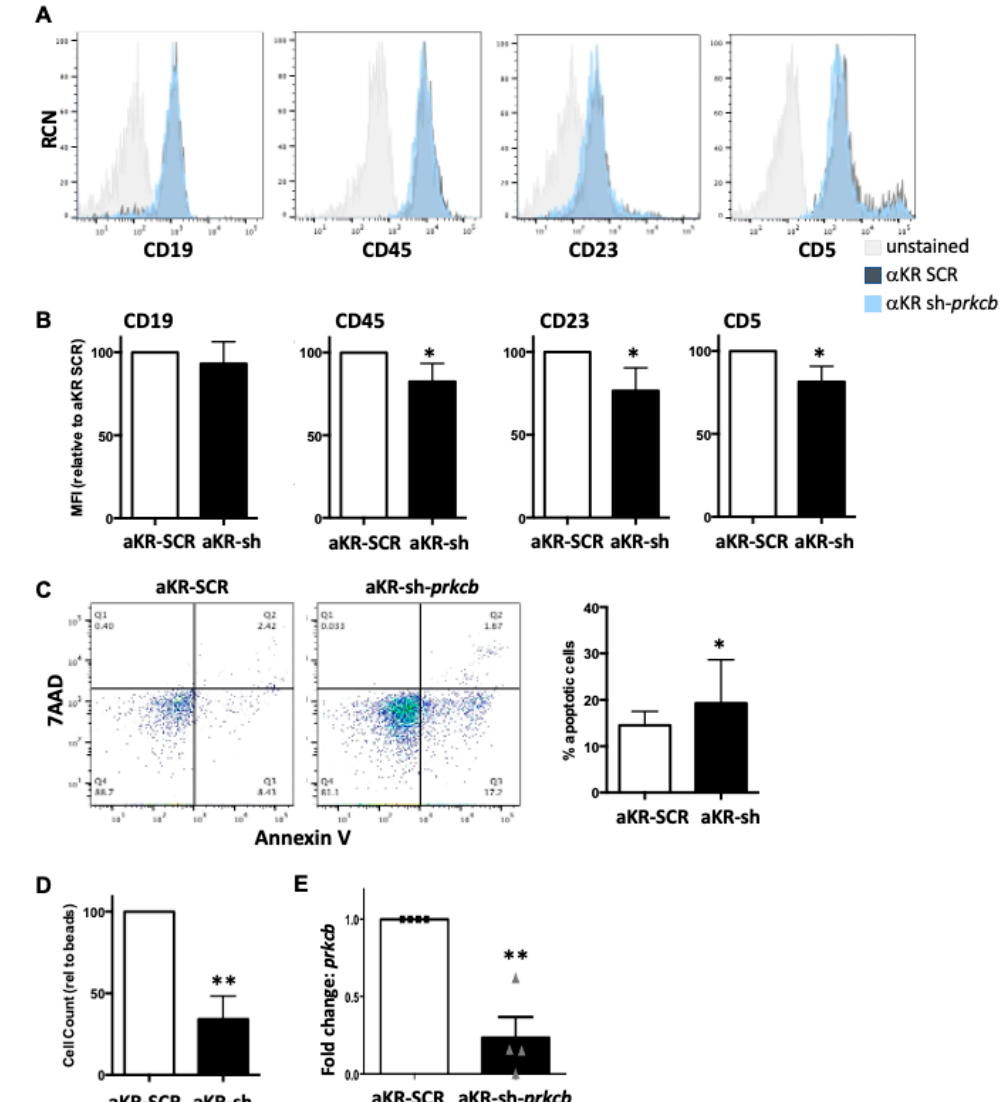
Figure 1. Reduction in PKC β expression inhibits the initiation of PKC α -KR-mediated CLL development. Knockdown of prkcb (or scrambled (SCR) control) was performed in HSPC cells within 24 h of isolation from the mouse, then these cells were retrovirally transduced with MIEV or PKC α -KR ( α KR) at d7. Cells were co-cultured with OP9 in the presence of cytokines for up to 35 days. Phenotypic characterisation of the cells was carried out by flow cytometry analysing: ( A ) CD19, CD45, CD23 and CD5. Representative histogram plots are shown, gated on FSC/SSC and GFP+ cells comparing α KR sh- prkcb cells with α KR-SCR cells compared with unstained cells (gating strategy shown in Supplementary Figure S1); ( B ) Average MFIs of CD19, CD45, CD23 and CD5 surface markers are shown relative to α KR-SCR cultures ( n = 5); ( C ) Apoptosis was determined by AnnV/7AAD staining. A representative dot plot shows Annexin V vs. 7AAD staining in α KR-SCR cells and α KR sh- prkcb . The graph shows the percentage apoptotic (AnnV+) cells present in cultures post d14 ( n = 5); ( D ) Cell counts were performed with flow cytometry using counting beads, shown relative to a set bead number acquired ( n = 5); ( E ) qPCR analysis of prkcb expression, α KR-SCR (circles) compared with α KR sh- prkcb (triangles). Gapdh was used as the reference gene and α KR-SCR-transduced cells were used as a calibrator ( n = 4). All experiments shown are representative of n ≥ 4 biological replicates as indicated. Paired student t -test with Wilcoxon matched-pair signed rank test was used to analyse the data. * p < 0.05, ** p < 0.01.